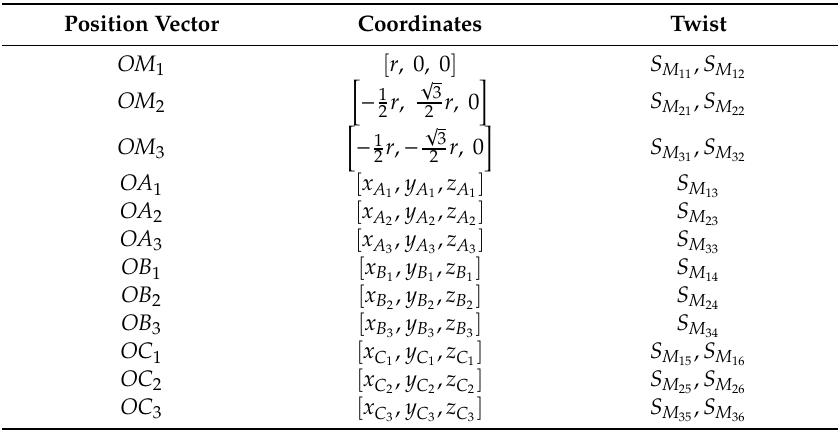
Table 3. Position vector and twist in a fixed coordinate